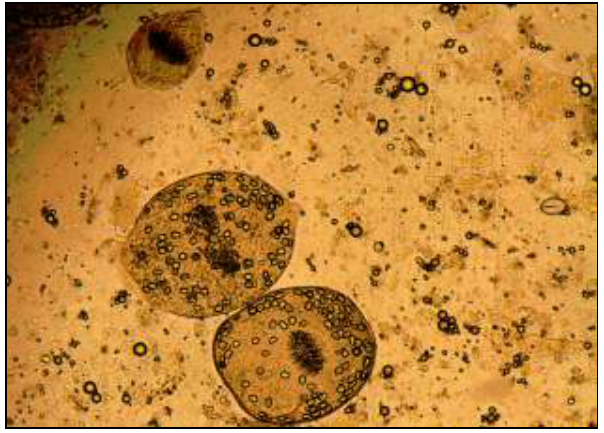
Figure-3: Hydatid sand in hydatid fluid collected from hydatid